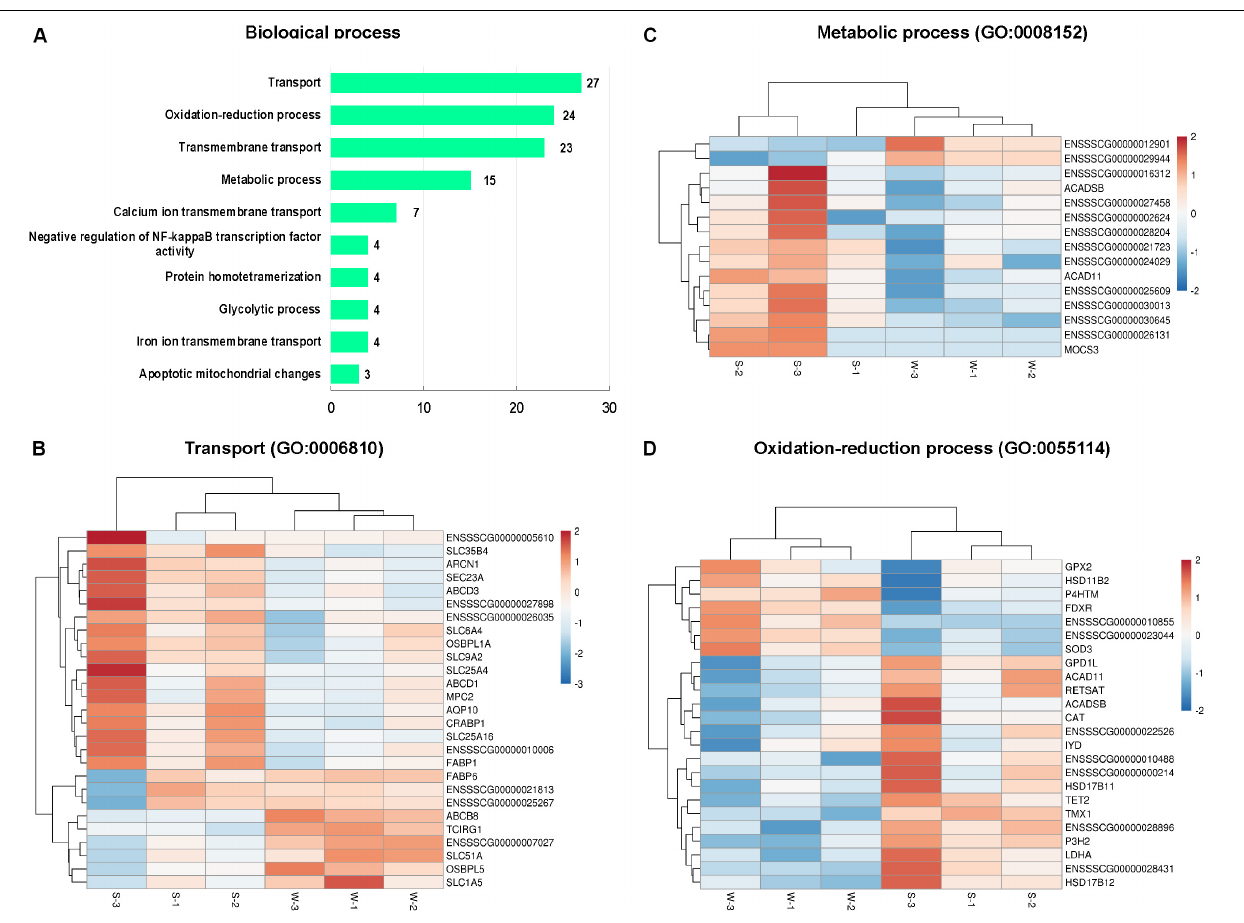
FIGURE 3 | Classification of biological process in the GO functional enrichment analysis of DEGs. (A) The top 10 terms in the biological process category. (B) Hierarchical clustering heat maps of DEGs in the GO term of transport (GO: 0006810). (C) Hierarchical clustering heat maps of DEGs in the GO term of metabolic process (GO: 0008152). (D) Hierarchical clustering heat maps of DEGs in the GO term of the oxidation-reduction process (GO: 0055114). S, sucking piglets; W, weaned